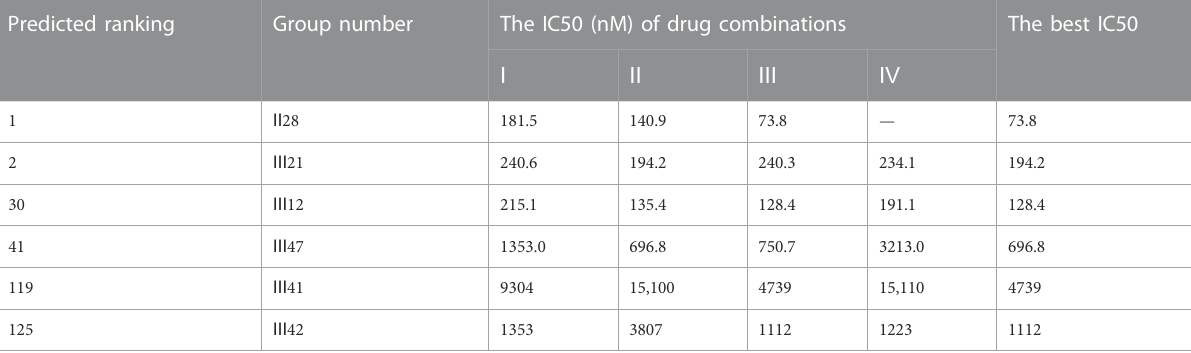
TABLE 10 The anti-cancer effects of drug combinations on A549 cells. Predicted ranking Group number The IC50 (nM) of drug